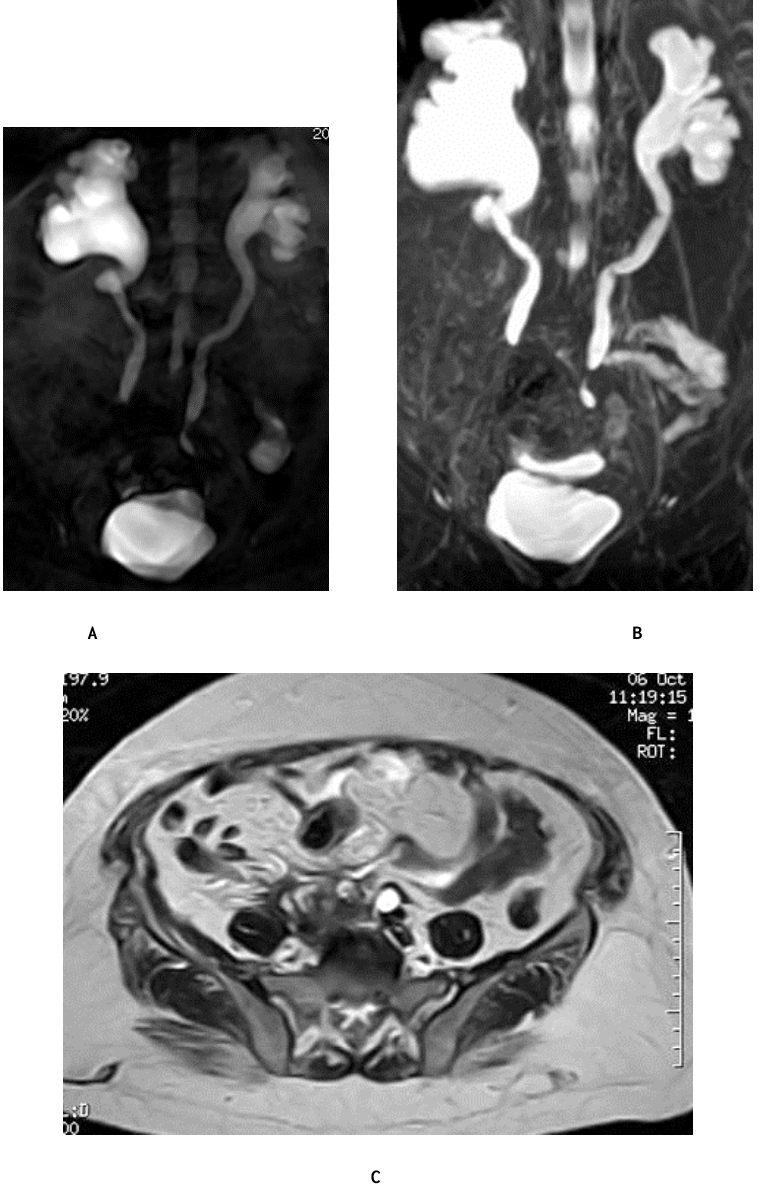
FIGURE 4. A case of bilateral ureteric obstruction secondary to retroperitoneal fibrosis. (A,B) Single-shot MRU and coronal reformatted MIP MRU show bilateral obstructed renal units down to the iliac ureters. (C) Axial T2w at the iliac region shows the retroperitoneal soft tissue mass involving both ureters at the pelvic